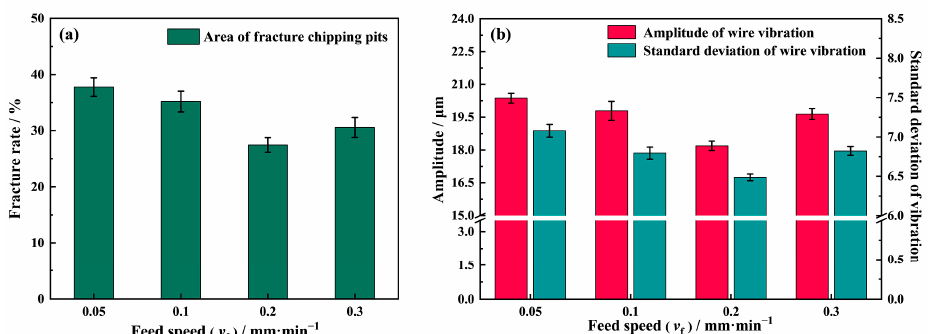
Figure 14. ( a ) Effect of the feed speed on the number of fracture chipping pits; ( b ) the amplitude of the wire vibration and the standard deviation (STD) of the wire vibration at P = 0.21 MPa, v s = 1.8 m/s.